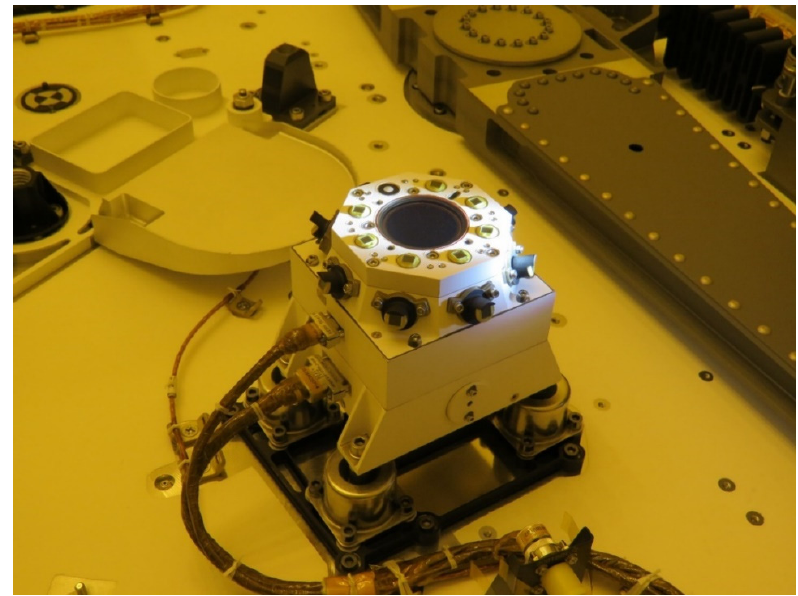
Figure 16. Final visual inspection of the RDS integrated on the Perseverance Rover. Table 1. RDS design final figures.